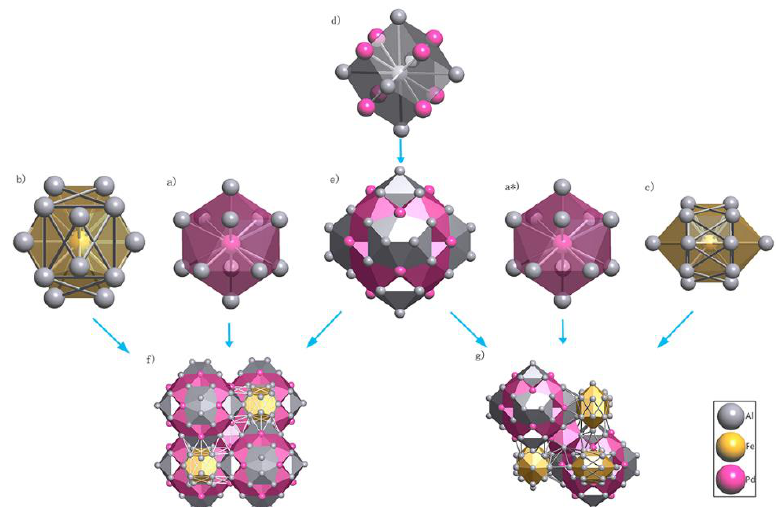
Figure 4. Building units and their packing around high symmetric positions in the C′ -phase. ( a ): the first building unit which is an icosahedra cluster; ( b ) the inner-shell of the second building unit; ( c ) the outer-shell of the second building unit; ( d ) packing pattern of one first building unit and four inner-shells; e) packing pattern of one first building unit and four second building units.